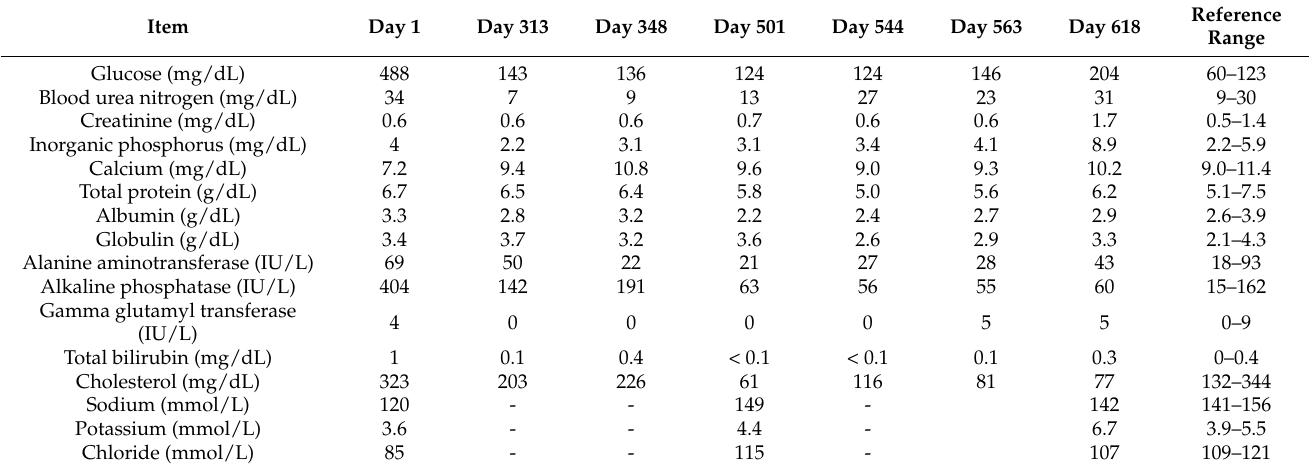
Table 1. Representative results of blood chemistry.